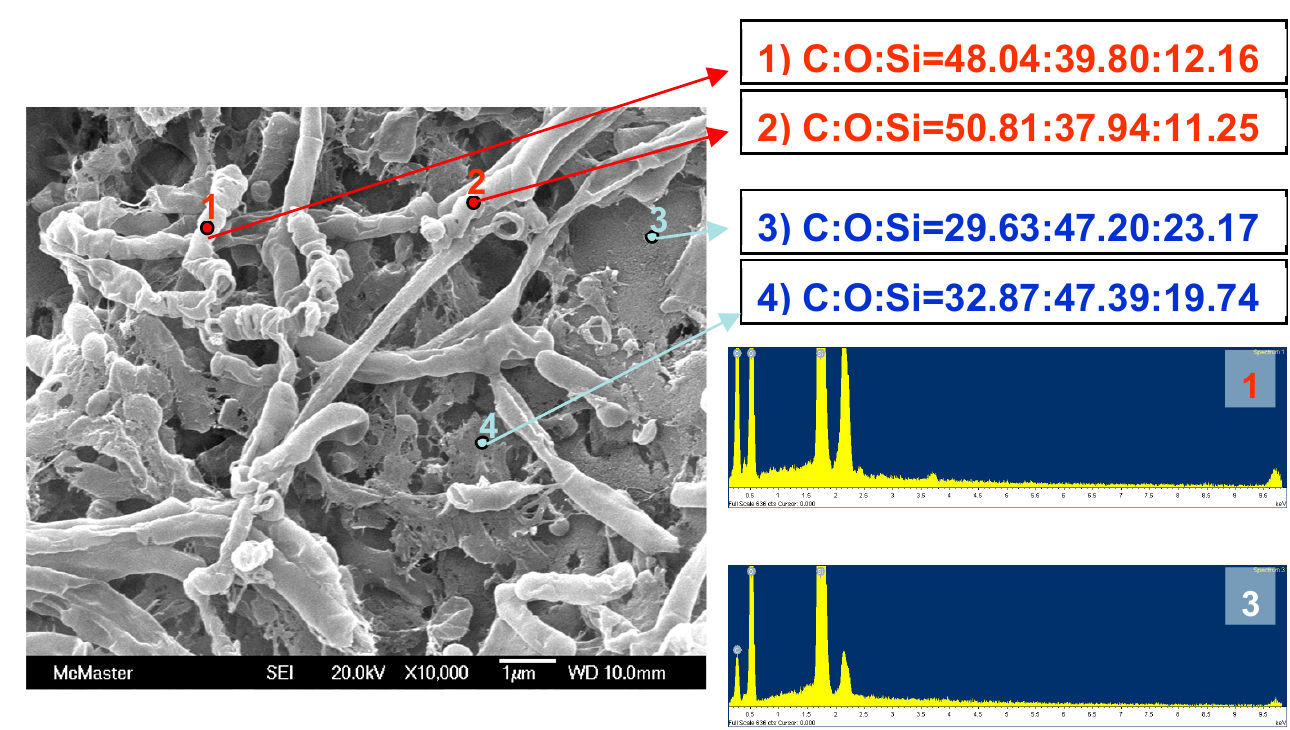
Figure 6. EDX analyses of worms and the background matrix. The numbers in the labels (right) show atomic percent ratios.